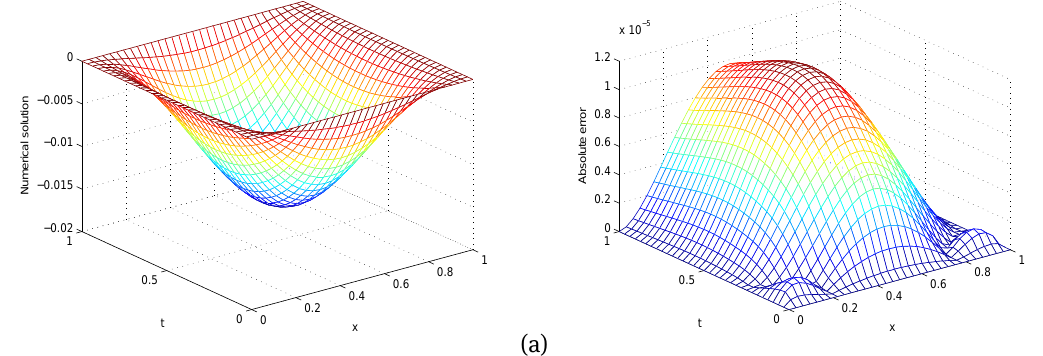
Figure 2: Numerical solution (a) and global error (b) for Example 2 with γ = 1.5 at T = 1 ( h = 1/32, τ = 1/32